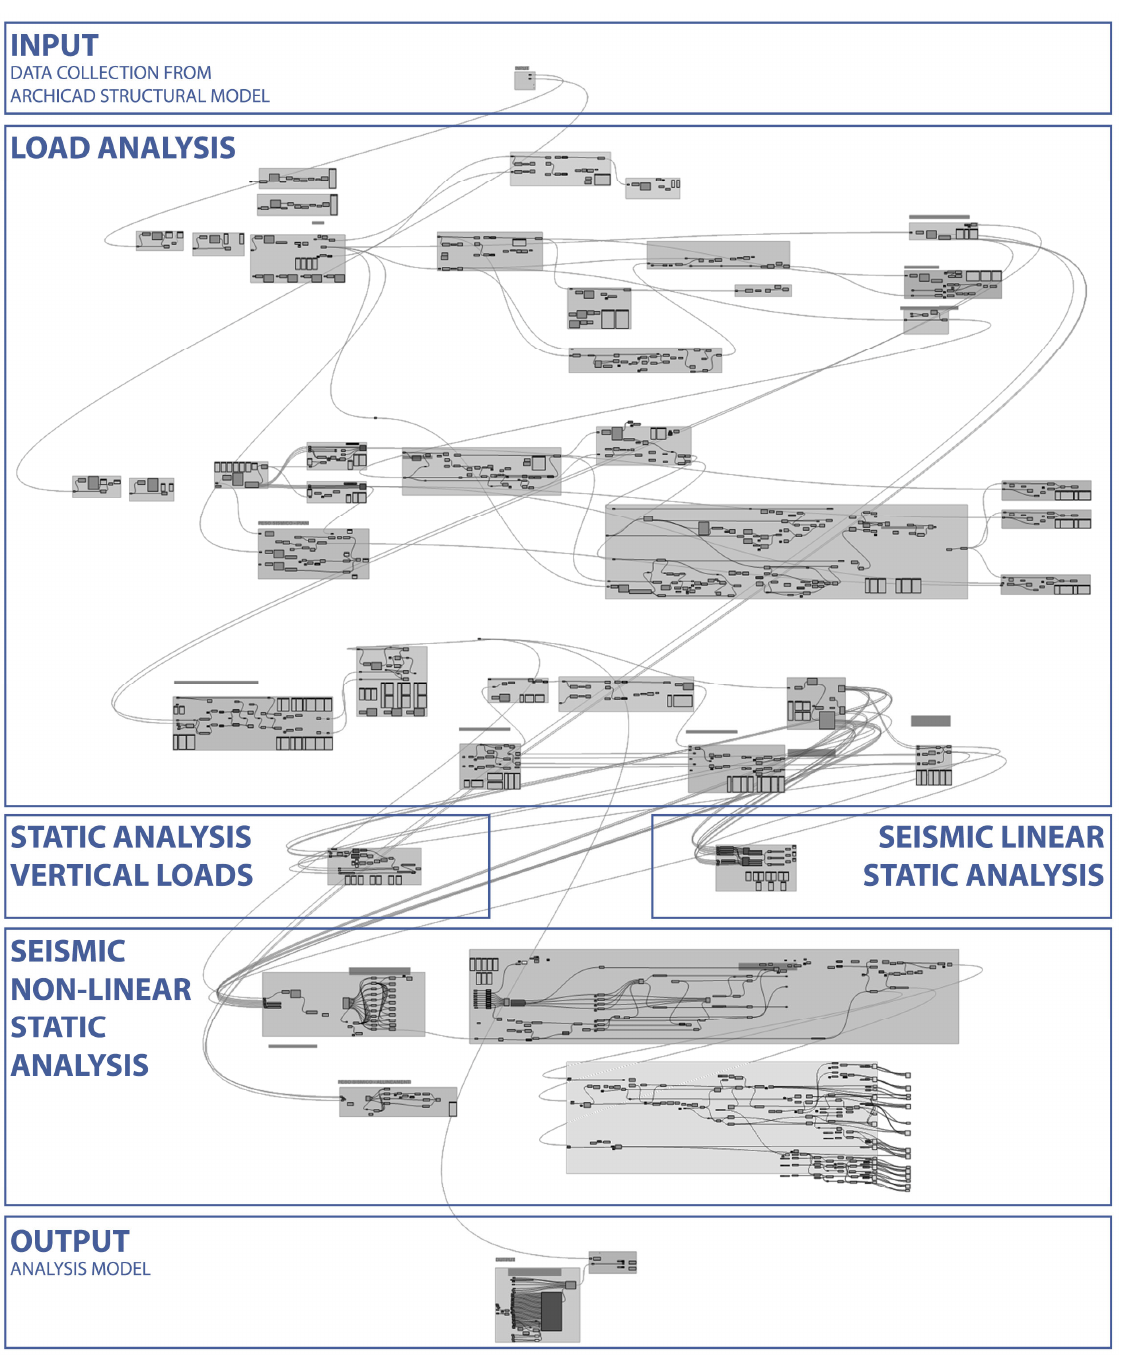
Figure 7. Code developed in Grasshopper to perform static verifications, linear and non ‐ linear static analysis of an existing masonry structure.